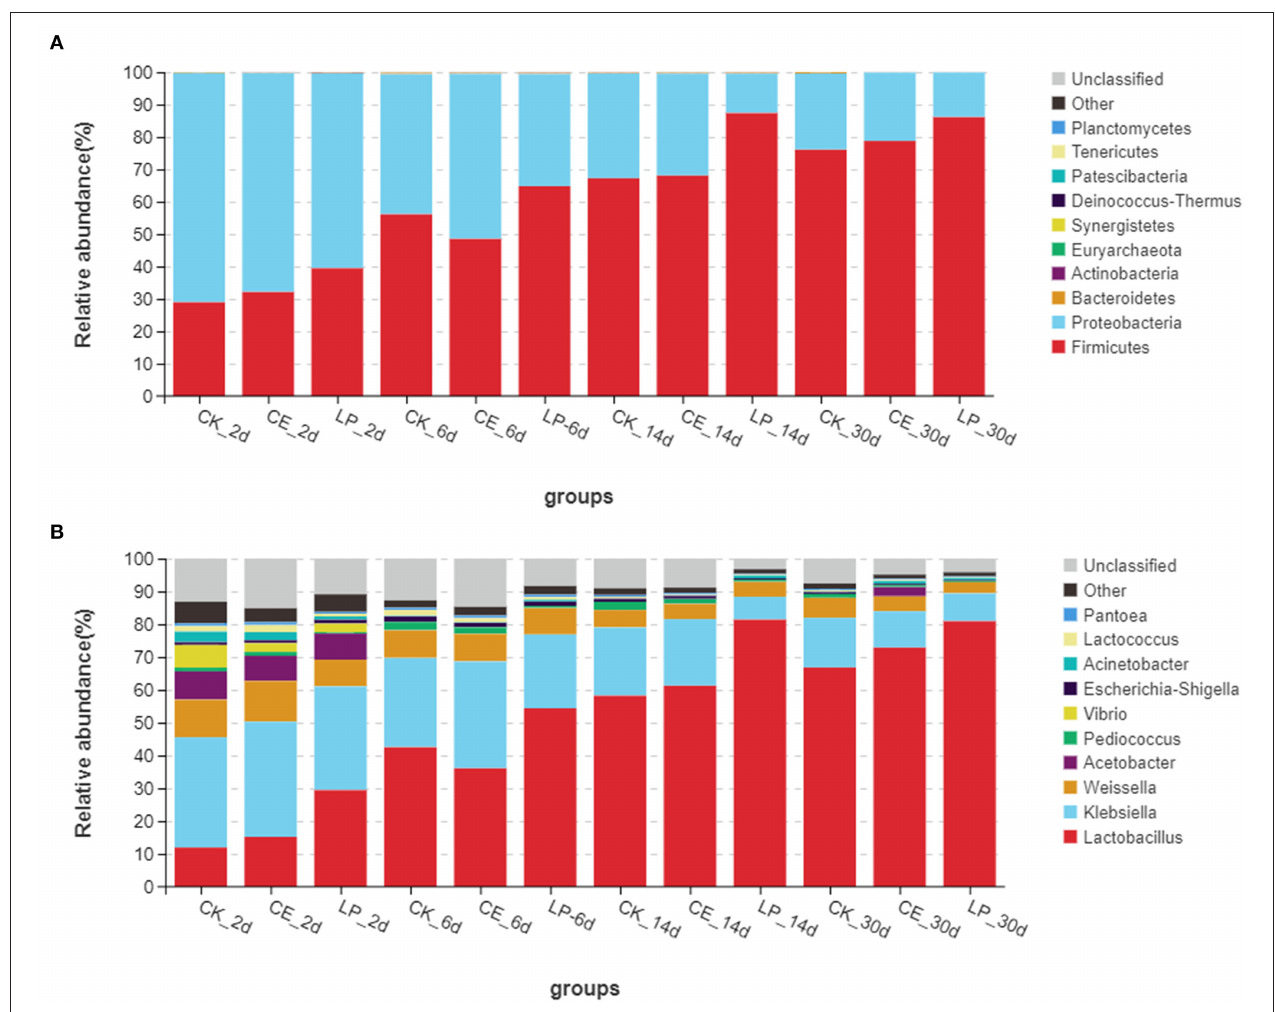
FIGURE 3 | Accumulation map of bacterial communities at the phylum (A) and genus (B) levels for cassia alata silage (CK, control; CE, cellulase; LP, Lactiplantibacillus plantarum , after 2, 6, 14, and 30 days of ensiling,